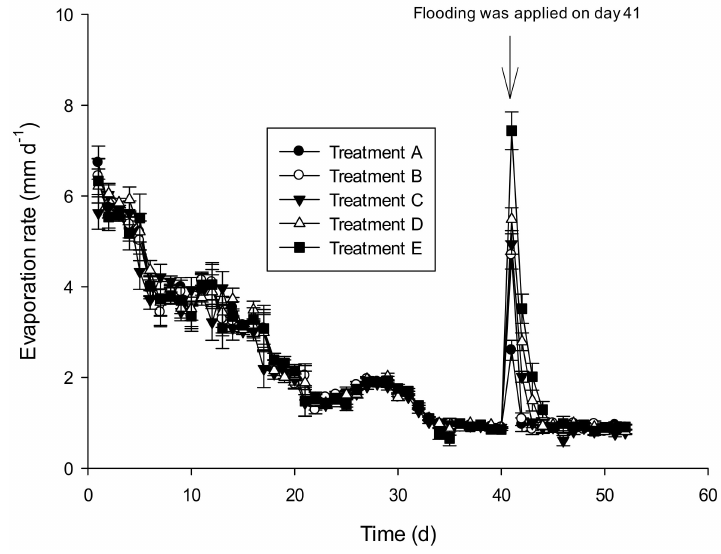
Figure 2. Daily variation in the evaporation rate in five